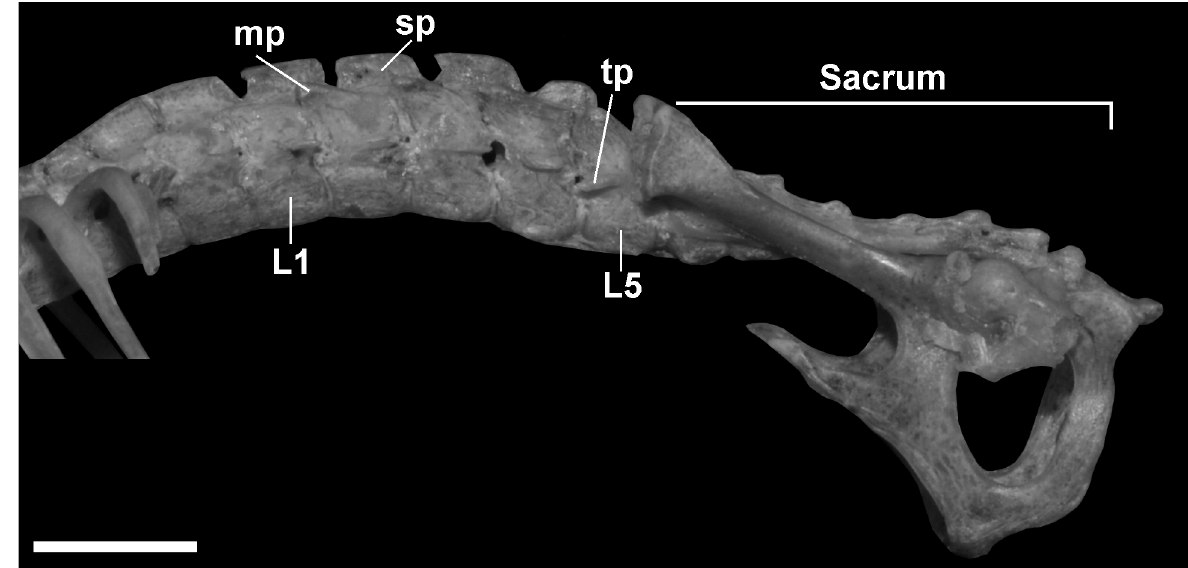
Figure 7 - Lateral view of lumbar vertebrae and sacrum of Chrotopterus auritus . Acronyms: L1: first lumbar vertebrae; L5: fifth lumbar vertebrae; mp: mammillary process; sp: spinous process; tp: transverse process. Scale bar represents 5